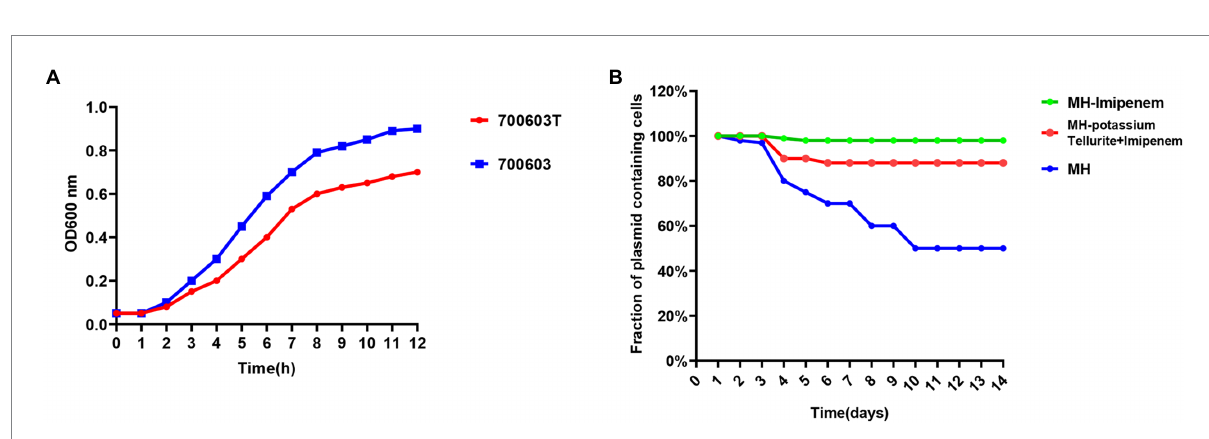
FIGURE 8 Growth curve measurements and stability of plasmids in 700,603 transformant. (A) Growth curves of the700603 transformant strain; (B) stability of plasmids in the 700,603 transformant strain in antibiotic and antibiotic-free